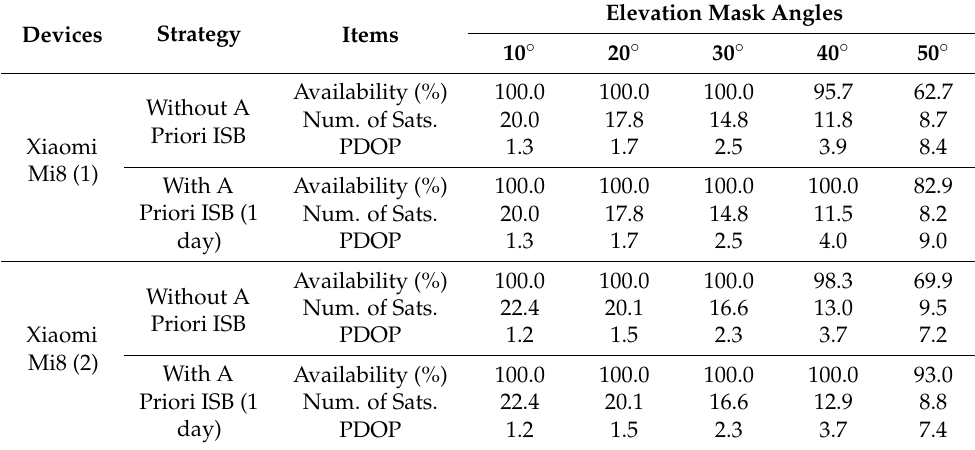
Table 10. Availability, satellite number, and PDOP value of four-system integrated SPP for two smartphones with and without a priori ISB constraints under different elevation